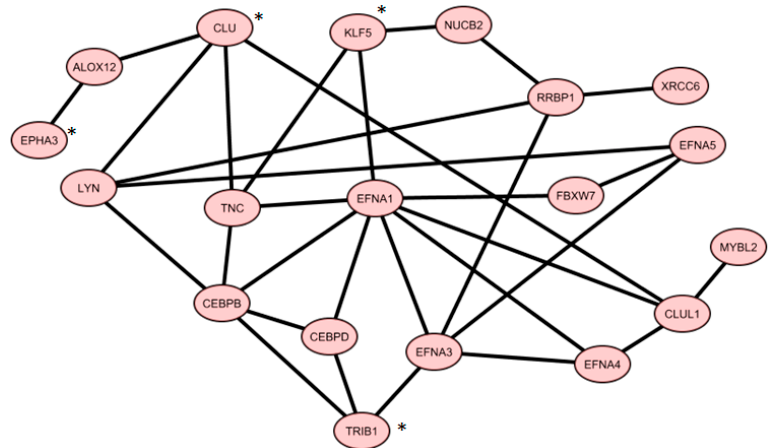
Figure 2. Co-expression gene network of core genes from four gene signatures overlapping with published gene signatures (* four gene signatures).